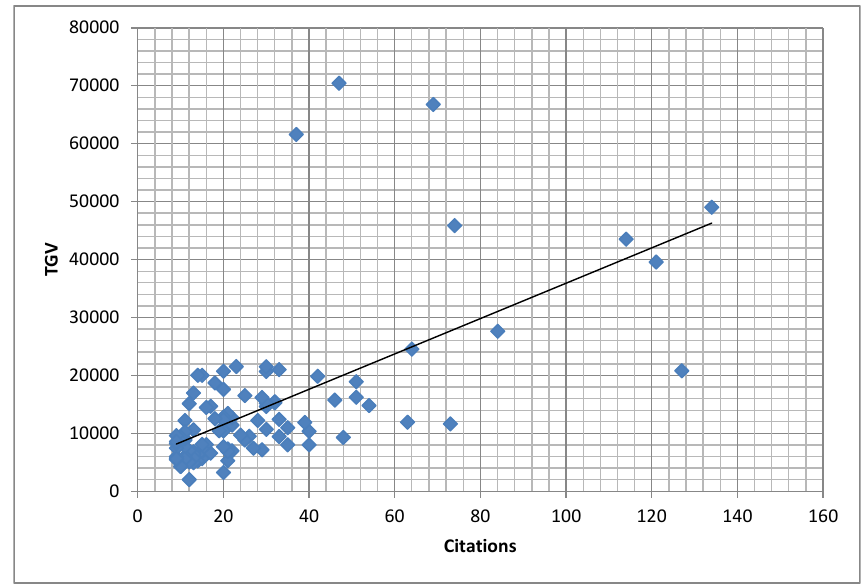
Figure 6. Scatterplot of the citations and